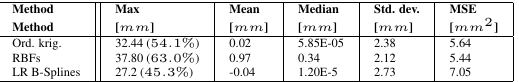
Table 1: Summary statistics for the error distribution of the cross validation.